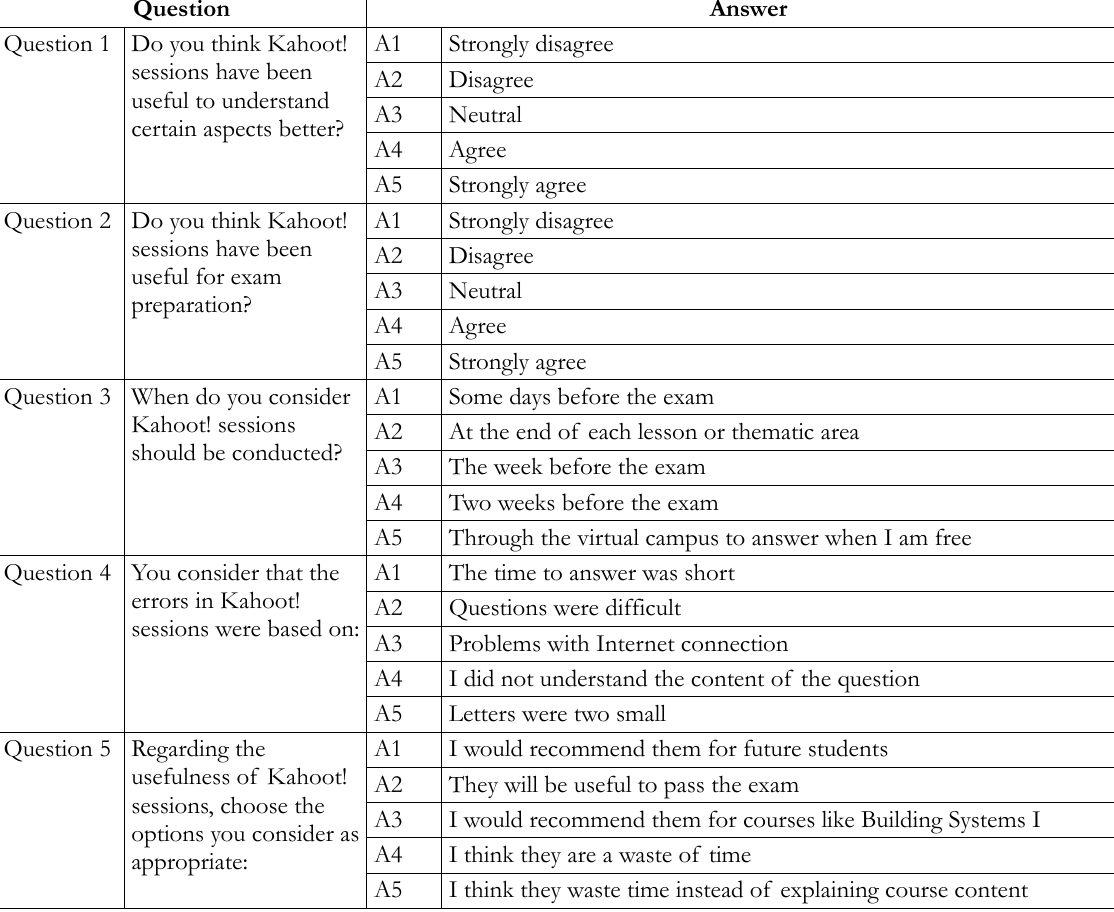
Table 1. Format of the student survey conducted through Google